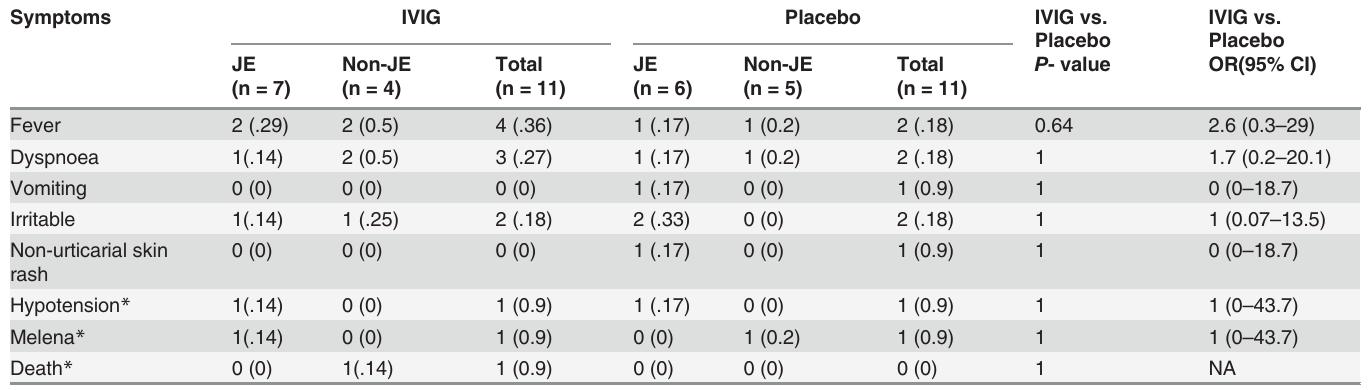
Table 2. Summary of adverse events.